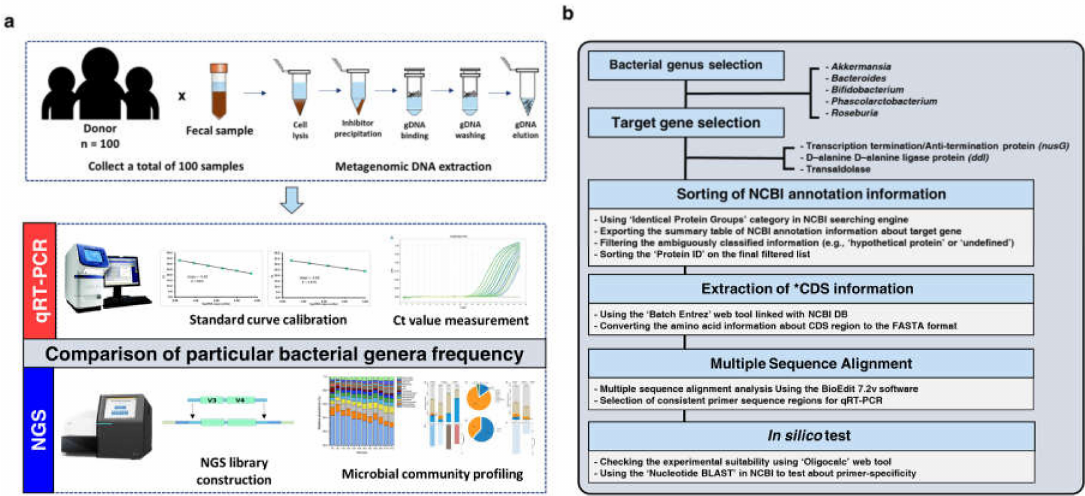
Figure 1. Experimental introduction in this study and schematic workflow of a genus-specific primer design method for qRT-PCR assay. Using stool samples obtained from 100 healthy adults, we performed a comparative analysis to evaluate the accuracy of microbial quantification by two different molecular technologies. ( a ) The overall experimental workflow of the qRT-PCR assay and NGS-based 16S V3-V4 metagenome sequencing. ( b ) Schematic diagram showing the process to design the genus-specific primer set to quantify the proportions of the five selected bacterial genera within each sample using qRT-PCR.